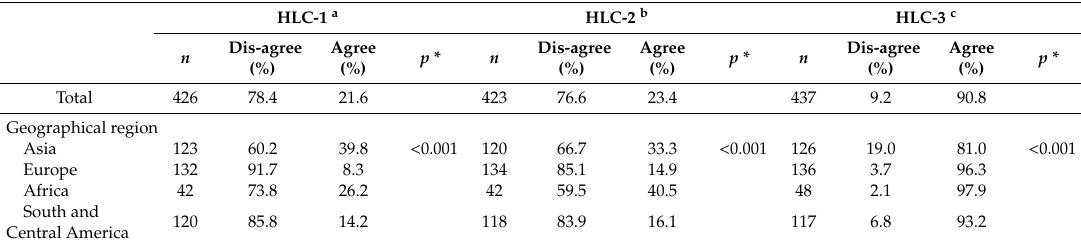
Table 3. Attitude towards Health Locus of Control (HLC) classified by geographical region.